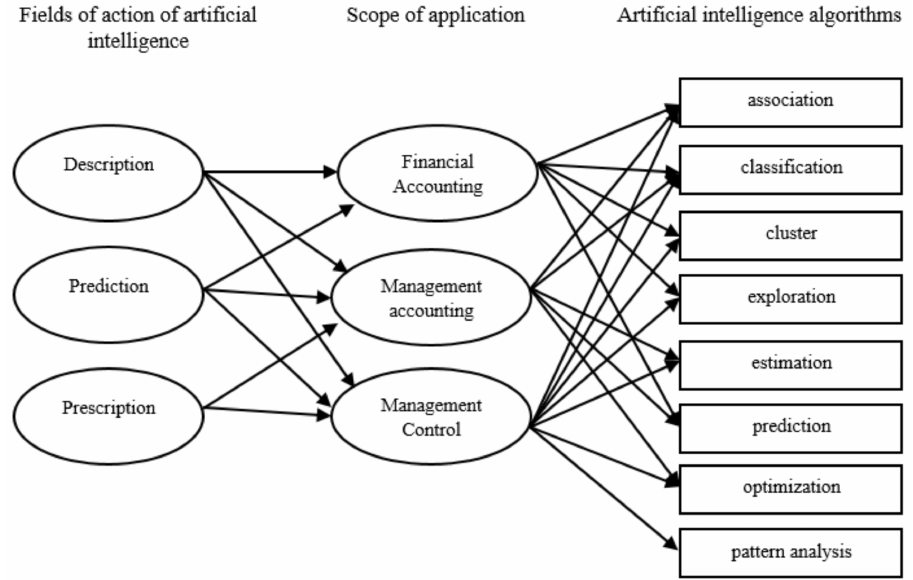
Figure 1. Fields of action, scope, and specific AI algorithms (adaptation from